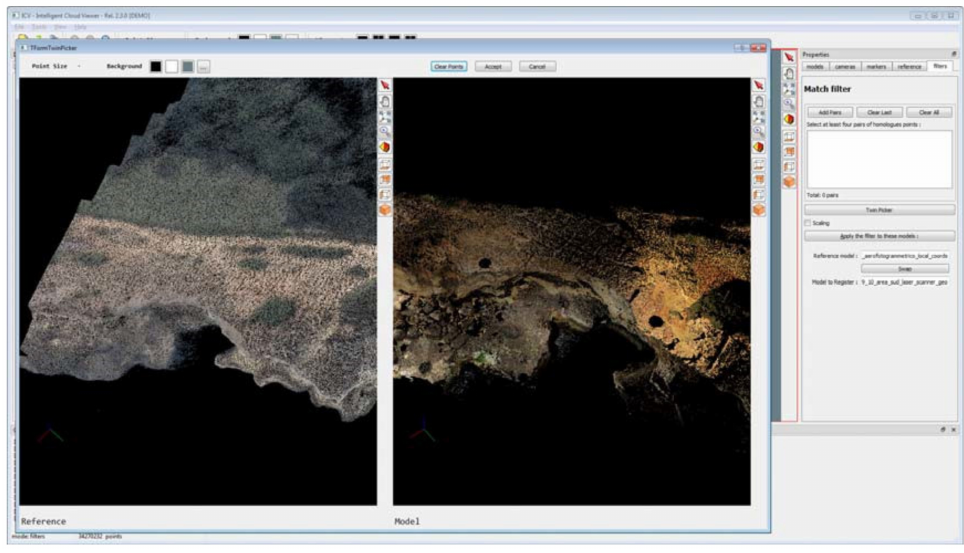
Figure 9. Visualization of the course registration process.